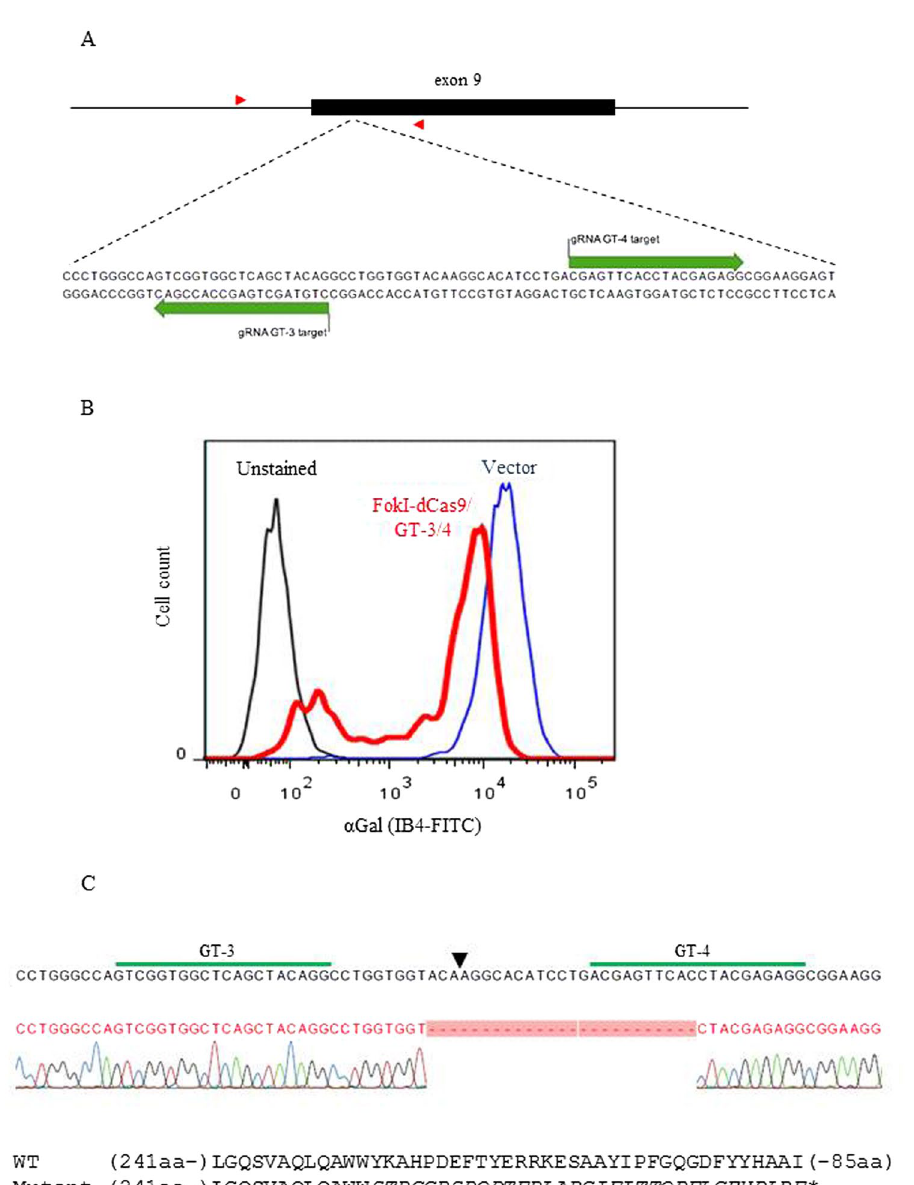
(#107) was analyzed further by PCR and sequencing, revealing precise knock-in of the 8.4 kb hTBM transgene into one allele of GGTA1 and a 14 bp deletion in the second allele (Suppl. Fig. 5C). Cloning and analysis of anti-CD2 knock-in pigs. Anti-CD2 mAb knock-in clone #3 was used to gener- ate pigs by somatic cell nuclear transfer (SCNT). Nine transfers of 90–130 reconstructed one-cell embryos were performed, resulting in two pregnancies. One pregnancy was carried to term and produced four live born male piglets, of which two died of natural causes shortly after birth. The surviving piglets were healthy and developed